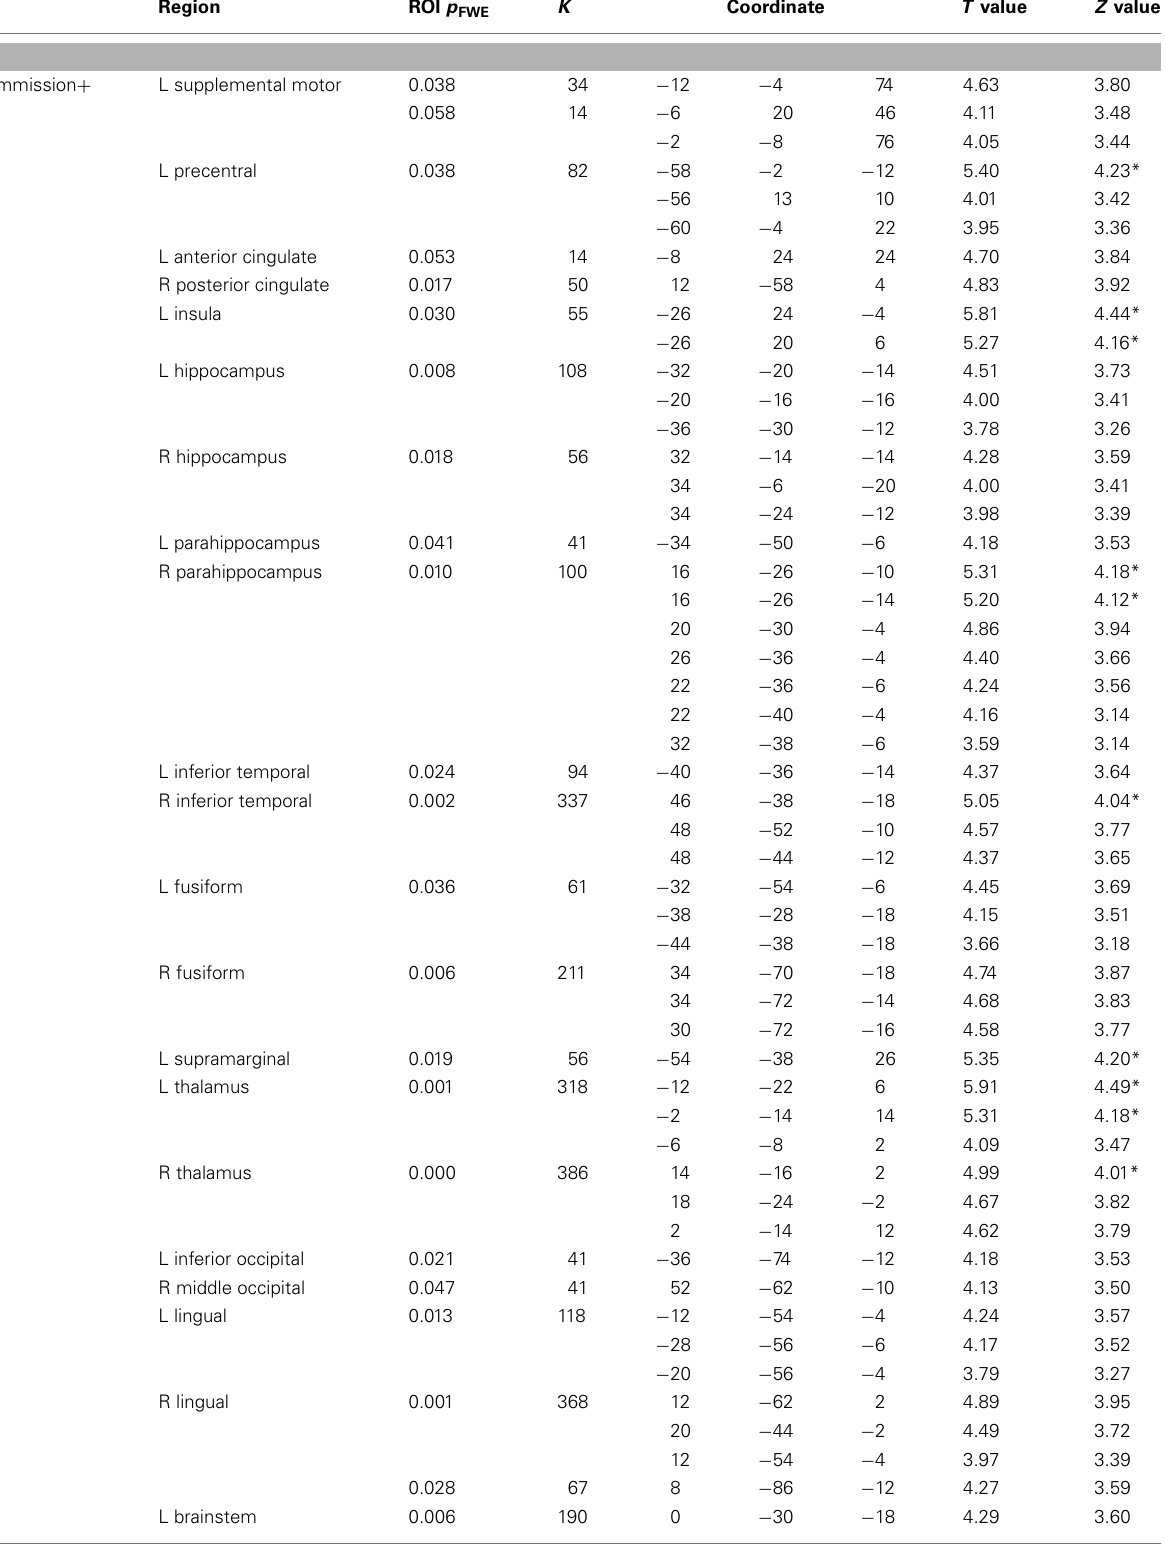
Table 5 | Significant regression results for errors of commission, reaction times, and days since surgery. Condition Region ROI p FWE K Coordinate T value Z